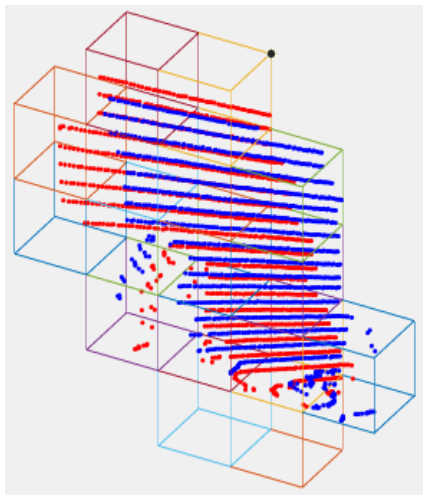
Figure 3- Correspondence points which are in same voxel (1st scan is red and 2nd scan is